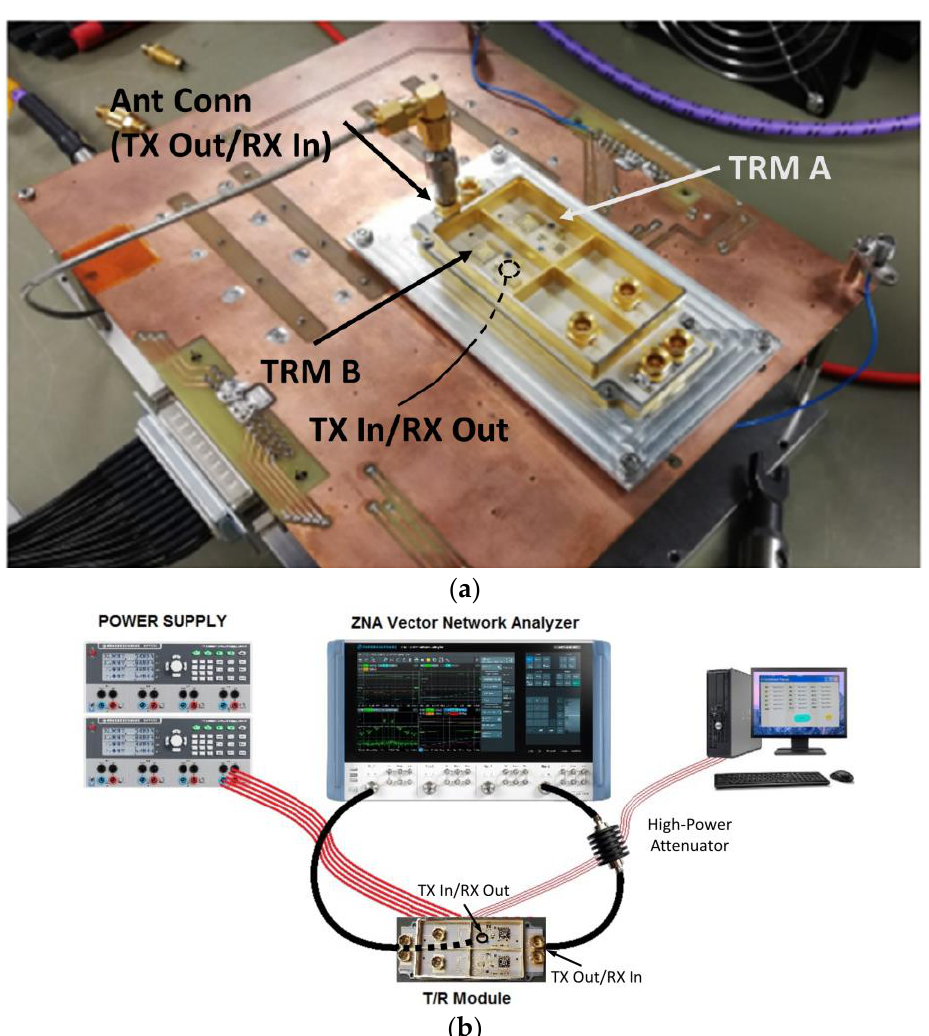
Figure 12. ( a ) Experimental setup of the quad-TRM. ( b ) Schematic overview of the complete setup. A PCB card was developed in order to correctly route all the DC and digital control signals to the TRM and generate the pulsed voltage to switch the gates of the power amplifiers of the SCFE. The quad-module TRM was mounted on an aluminum carrier for thermal and mechanical requirements and was screwed to the large PCB. All DC signals, properly RF filtered, were routed on the PCB from the TRM DC pads at the bottom of the module to a multipin connector and, from this, with an appropriate wiring, to the power supply. As for DC signals, all digital signals (i.e., clock, data) were routed, through the PCB and a dedicated connector, from the digital pads of the TRM to the parallel port of the controller